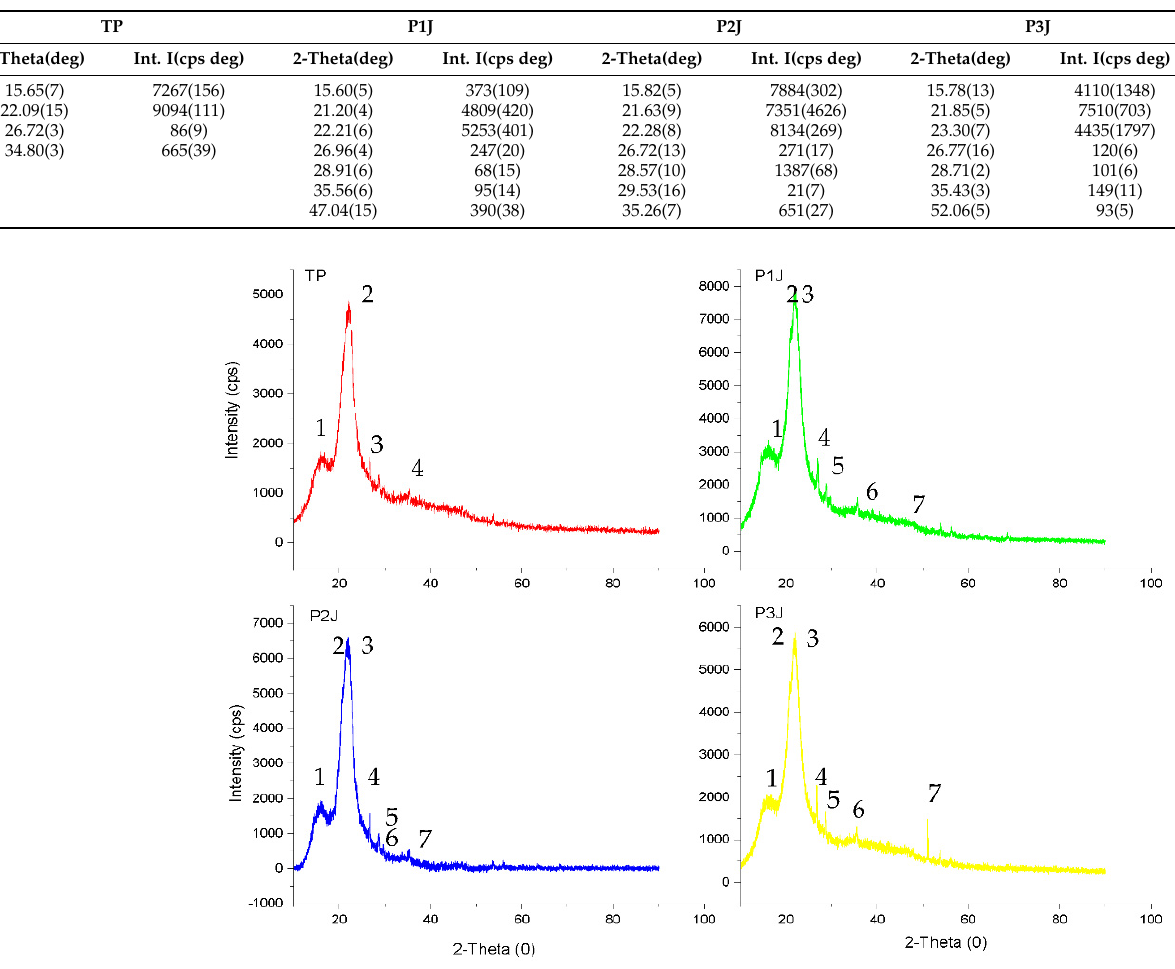
Figure 6. The intensity comparison of the BSF XRD test (TP, P1J, P2J, and P3J).